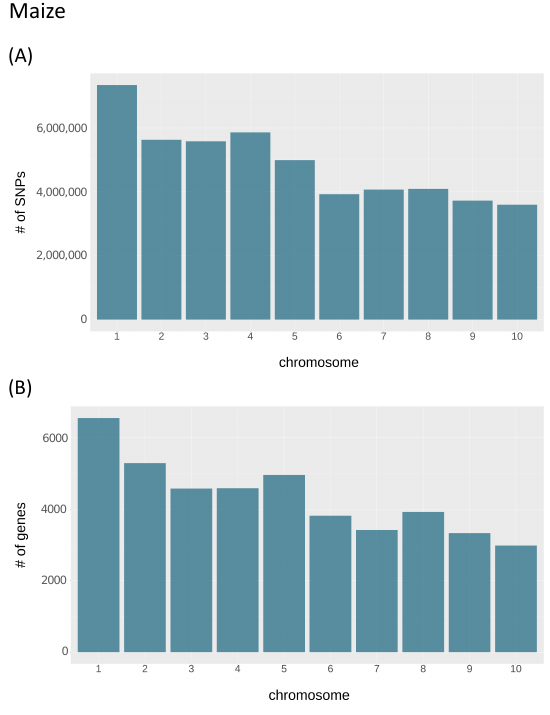
Figure 2. The total number of SNPs and genes per chromosome of maize ( Zea mays ). ( A ) The number of SNPs per chromosome. ( B ) The number of genes per